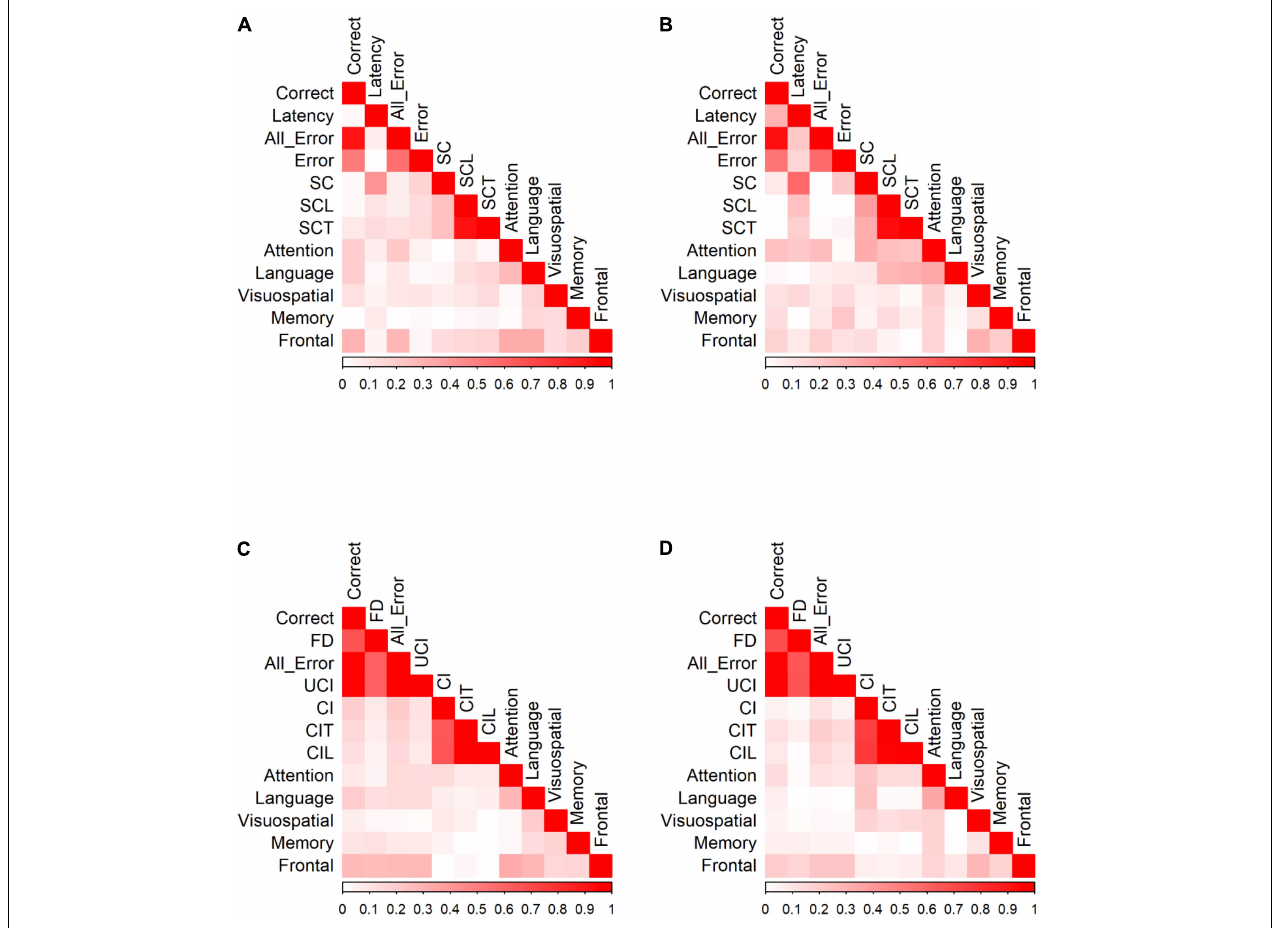
FIGURE 5 | Correlation of Go/No-Go responses and neuropsychological tests for (A) Go responses by HC. (B) Go responses by MCI patients. (C) No-Go responses by HC. (D) No-Go responses by MCI patients. Data were presented with the absolute values of Pearson correlation coefficients; exact values and p values are presented in Supplementary Table 2 (HC) and Supplementary Table 3 (MCI). FD, fixation duration, SC, self-corrected errors, SCL, self-corrected latency, SCT, self-corrected time, UCI, uncorrected-inhibition errors, CI, corrected inhibition errors, CIL, corrected inhibition latency, and CIT, corrected inhibition time. Weak correlations, near 0, are in white while those nearing 1 are in red, portraying strong correlations. Pearson’s correlations are in absolute